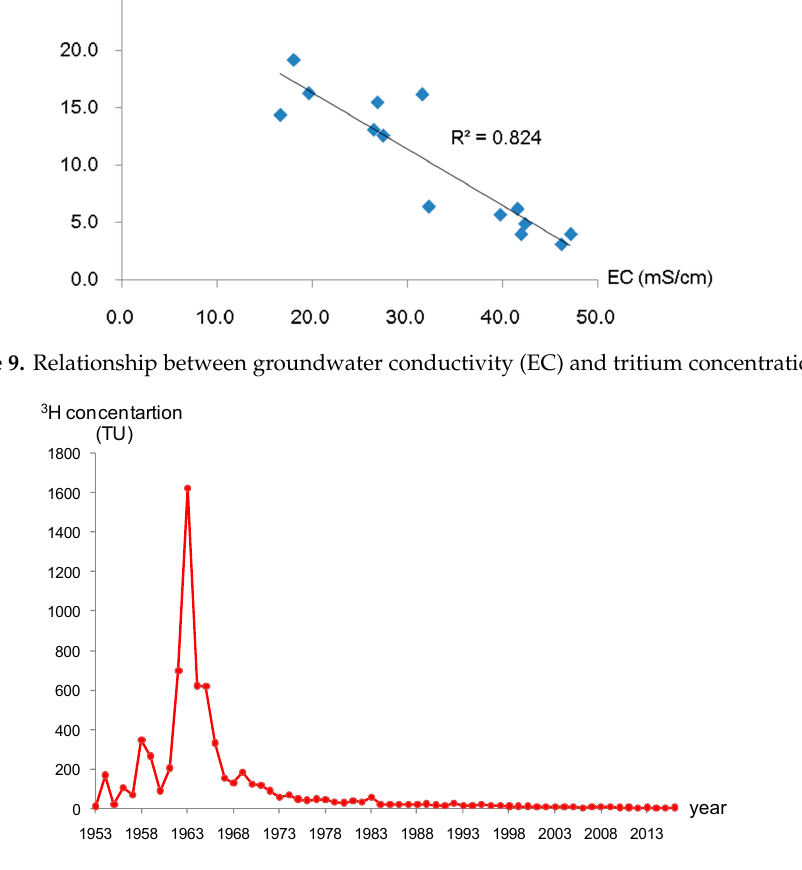
Figure 10. Reconstructed tritium concentration series in precipitation in the study area.